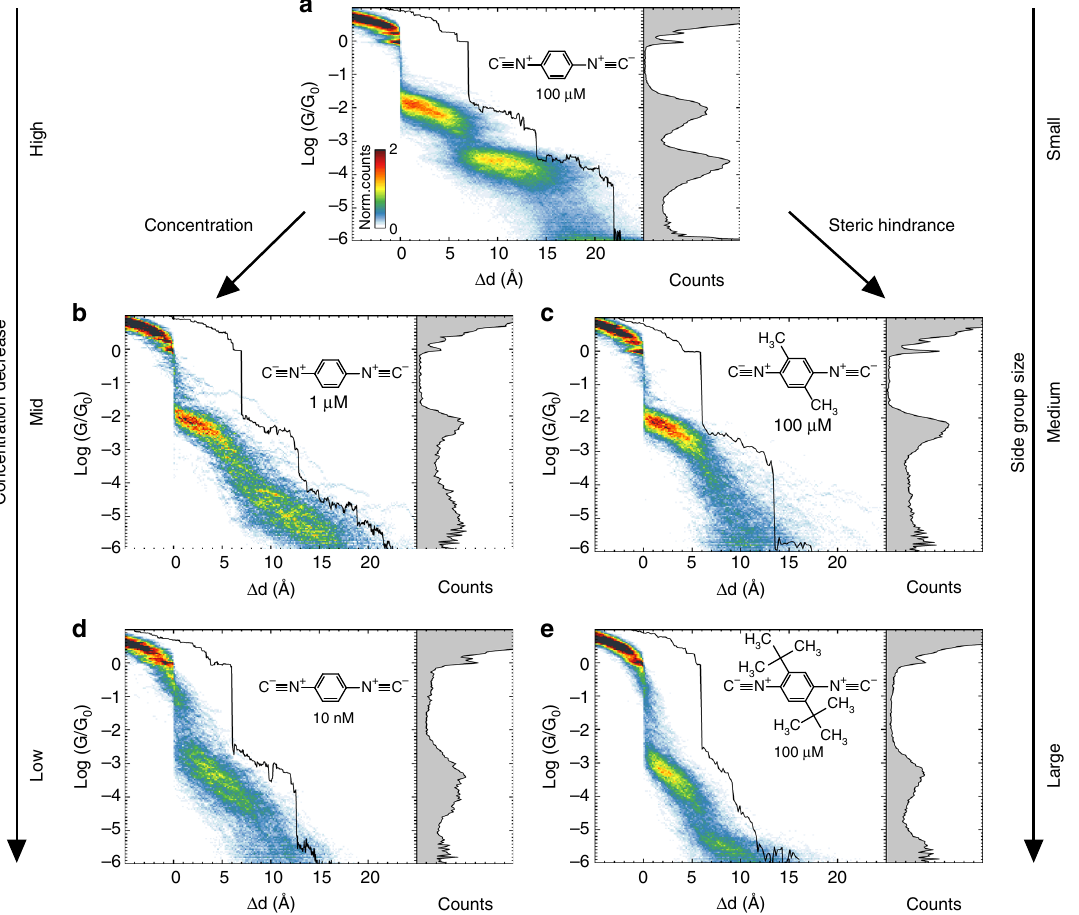
Fig. 4 Concentration and steric hindrance effect on the chain formation. Combined 2D – 1D histograms for ( a ) 100 μ M BdNC solution measurement (1445 traces), lower concentration measurements: b 1 μ M BdNC solution (350 traces), d 10 nM BdNC solution (200 traces), and measurements for BdNC derivatives with side groups: c 100 μ M MBdNC (374 traces) and ( e ) 100 μ M tBuBdNC solution (565 traces). Typical opening conductance trace is shown for every